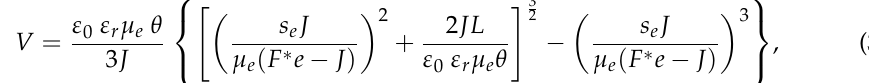
saturation is reached at 150 V. For the highest photon flux, F = 2.36 × 10 13 cm − 2 s − 1 , the saturation is reached at 450 V. Solid lines are fitted to the Ridzonova et al. model.